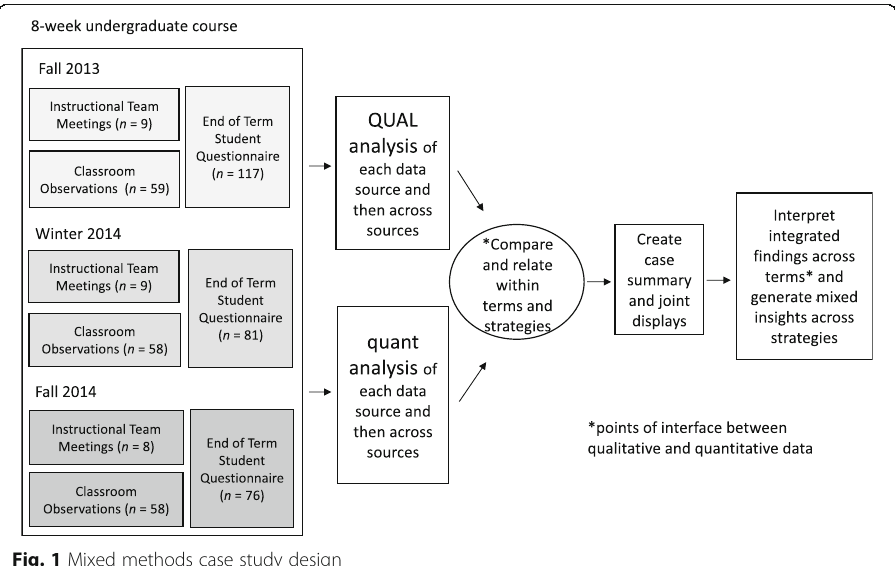
Fig. 1 Mixed methods case study